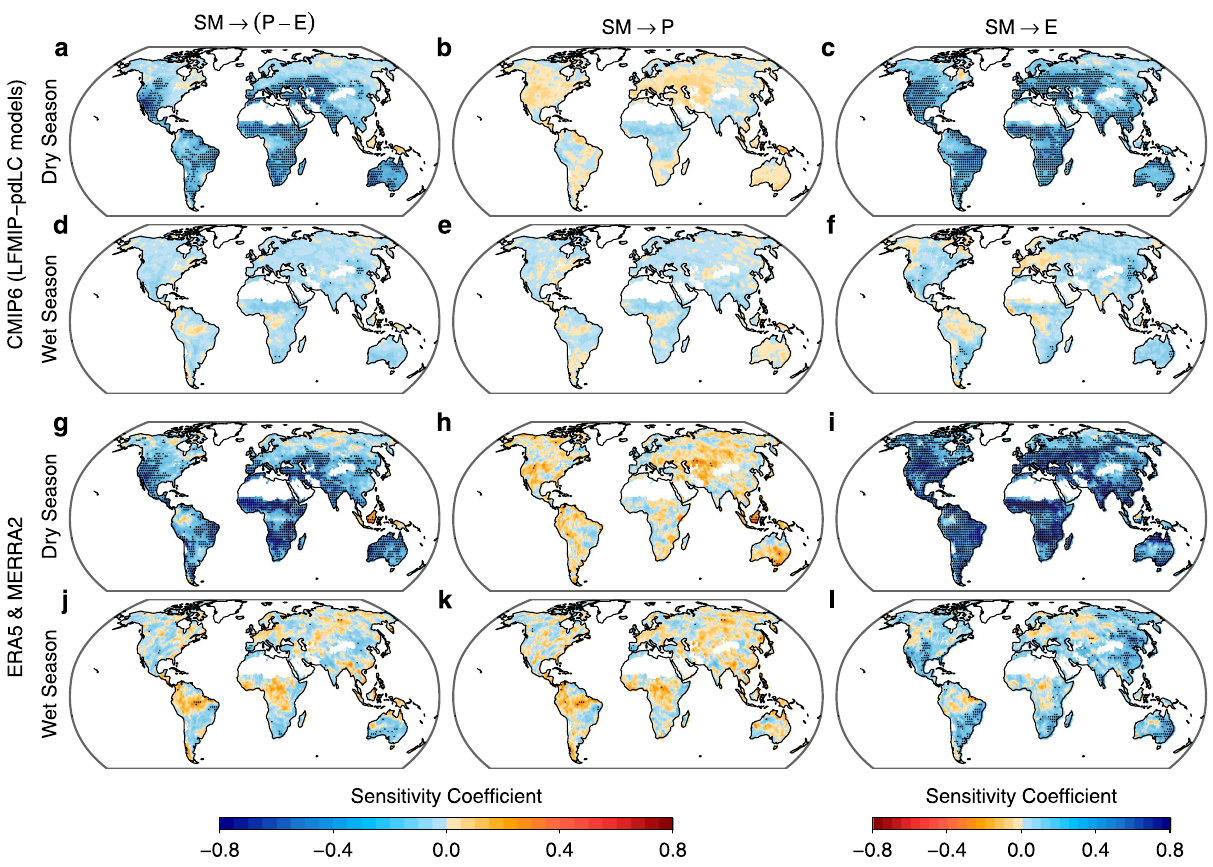
Fig.4|Soilmoisturefeedbacksonwateravailabilityinthewetanddryseasons. a – f Mean sensitivity coef fi cients for soil moisture (SM) → precipitation minus eva- potranspiration (P-E), SM → P, and SM → E identi fi ed based on historical and SSP585 simulations (1980 – 2100) of the fi ve CMIP6models whichparticipate inthe LFMIP-pdLCexperiment. g – l Thesameas( a – f ),butformeansensitivitycoef fi cients from reanalysis products ERA5 (1979 – 2019) and MERRA-2 (1980 – 2019) ( d – f ). The sensitivity coef fi cient for X → Y denotes the partial derivative of Y in the wet/dry